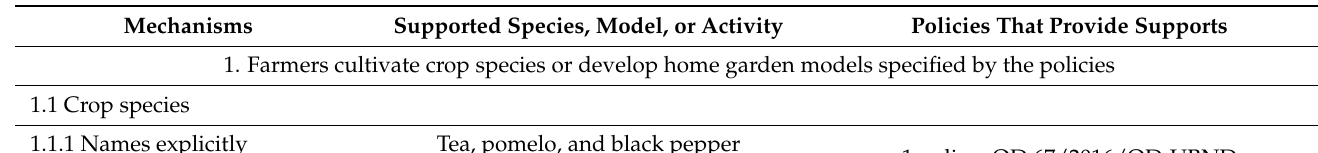
Table A4. Support mechanisms by the home garden